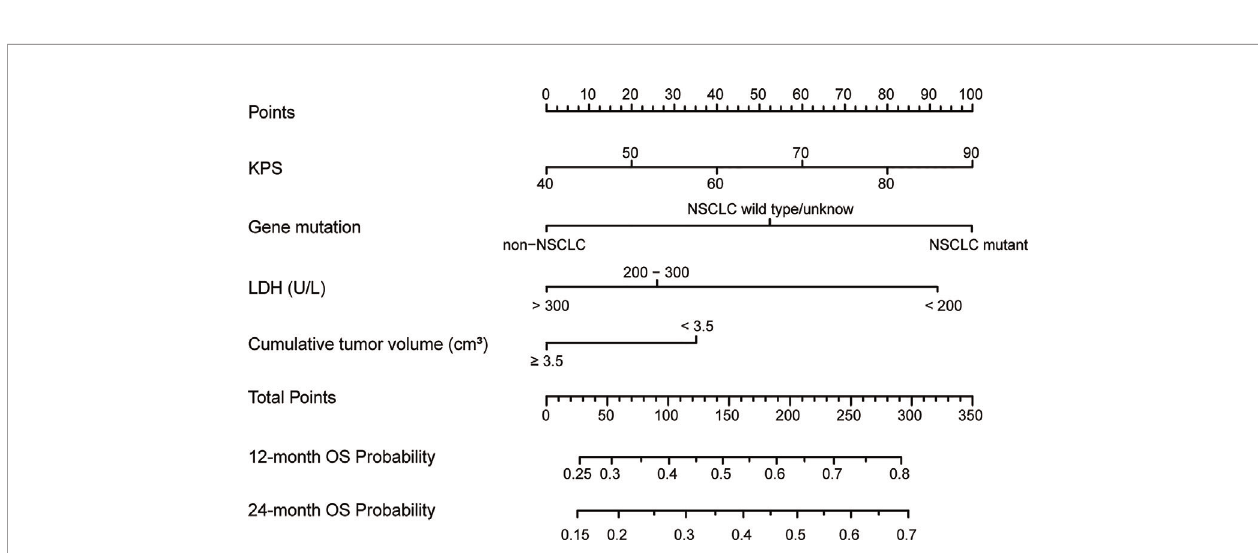
FIGURE 2 | The established nomogram to predict overall survival created based on four independent prognostic factors.